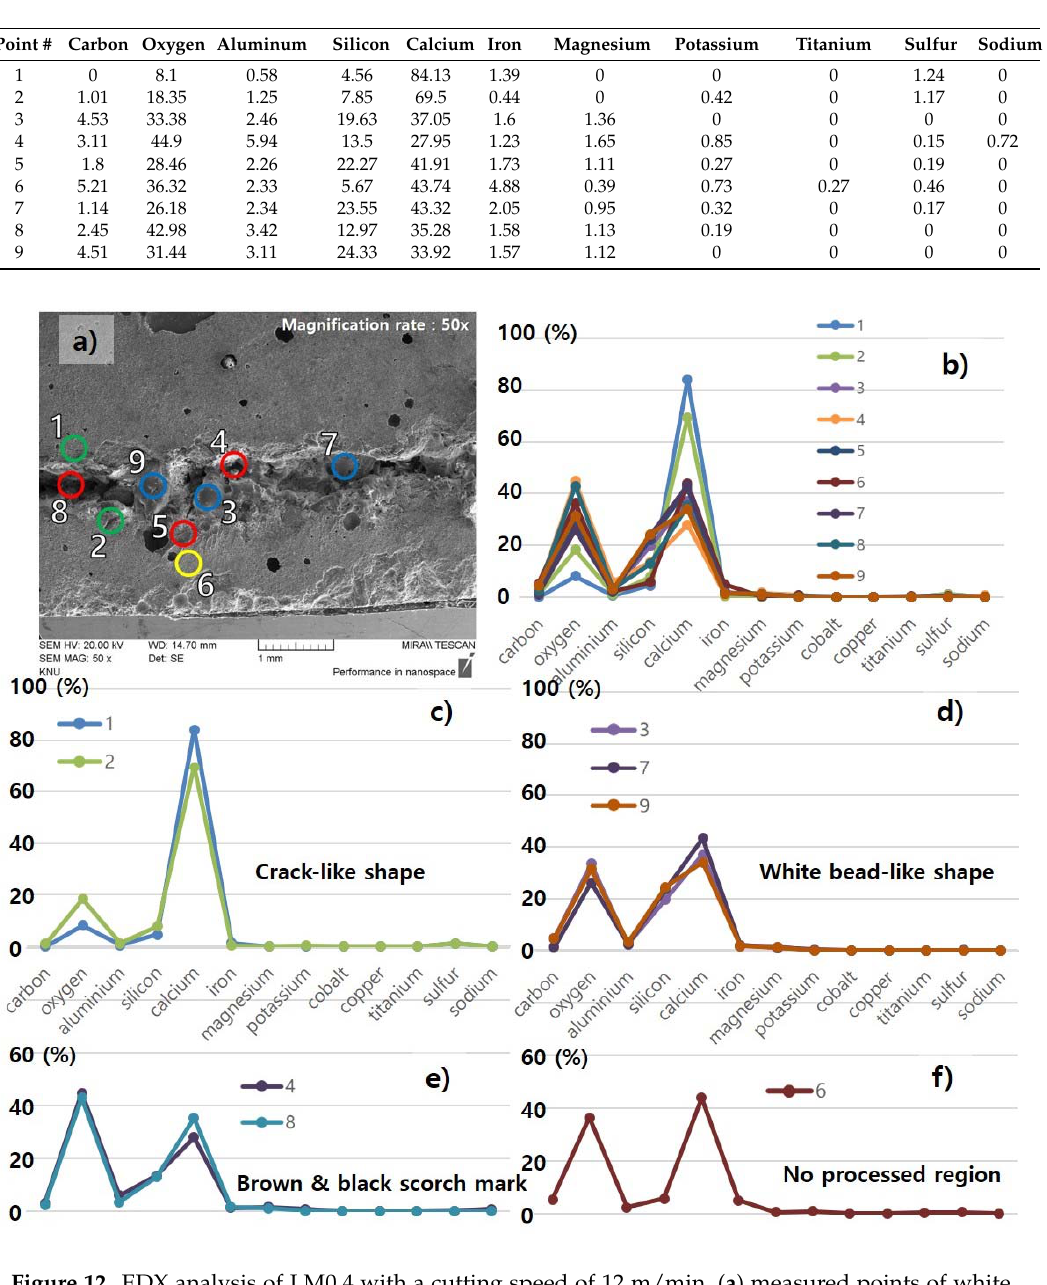
Table 4. Composition (wt %) by EDX analysis of LM0.4 with a cutting speed of 12 m/min. Measured points are specified in Figure 12.